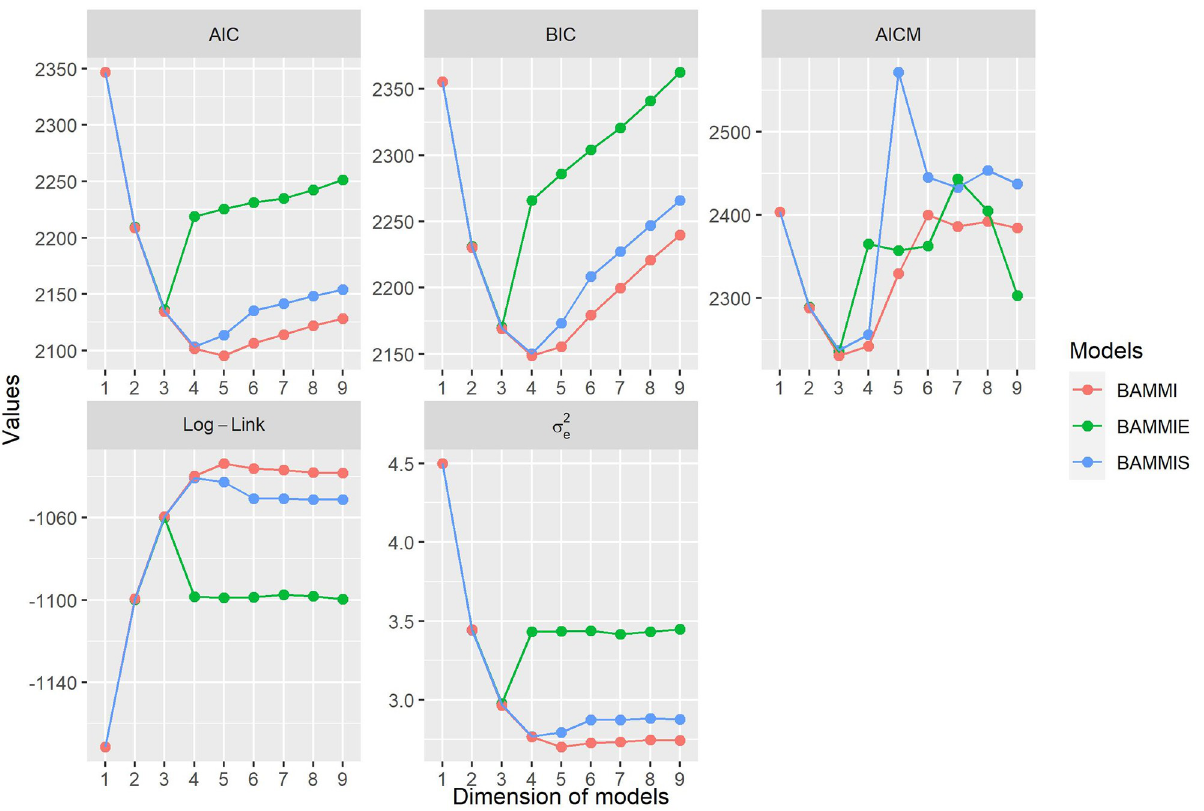
Fig 1. Ockham’s plot for the BAMMI, BAMMIS, and BAMMIE models for the AIC, AICM, and BIC information criteria, as well as for the log- likelihood (log-like) and residual variance (